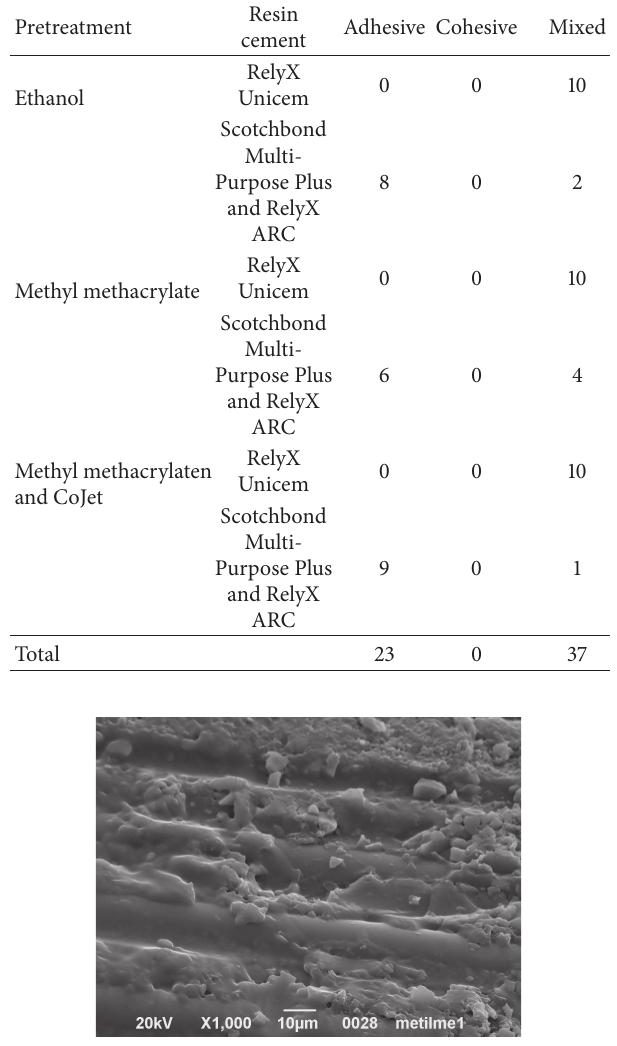
Figure6:SEMimageofthepostsurfaceaftertreatmentwithMethyl methacrylate for 1min